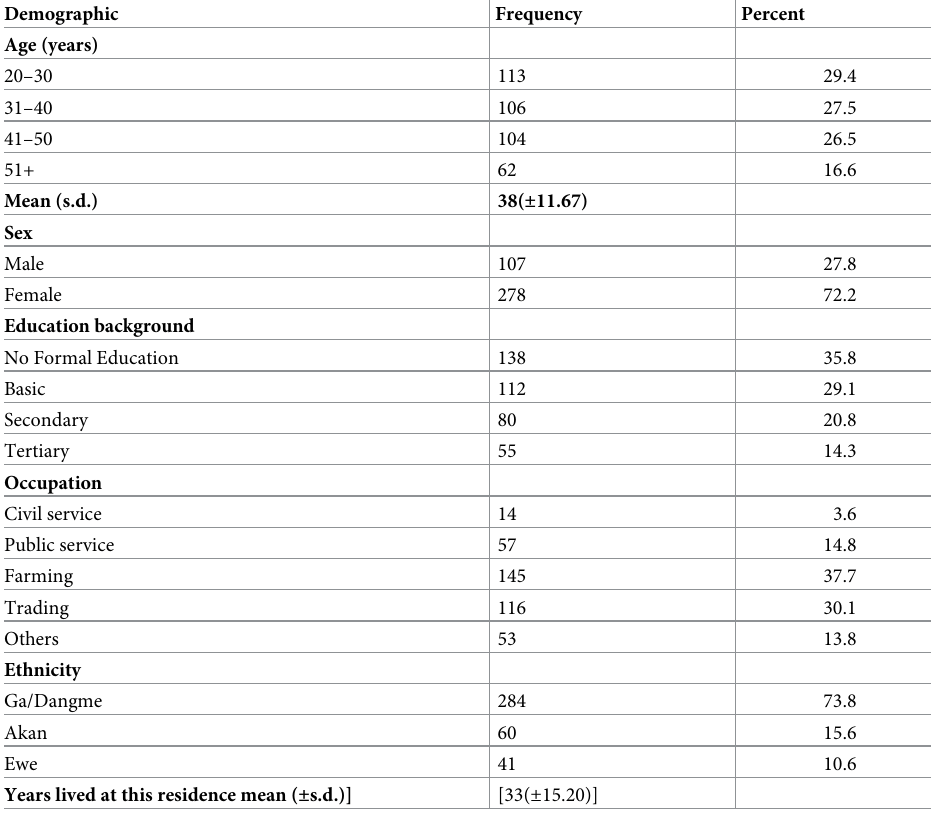
Table 2. Characteristics of household respondents.